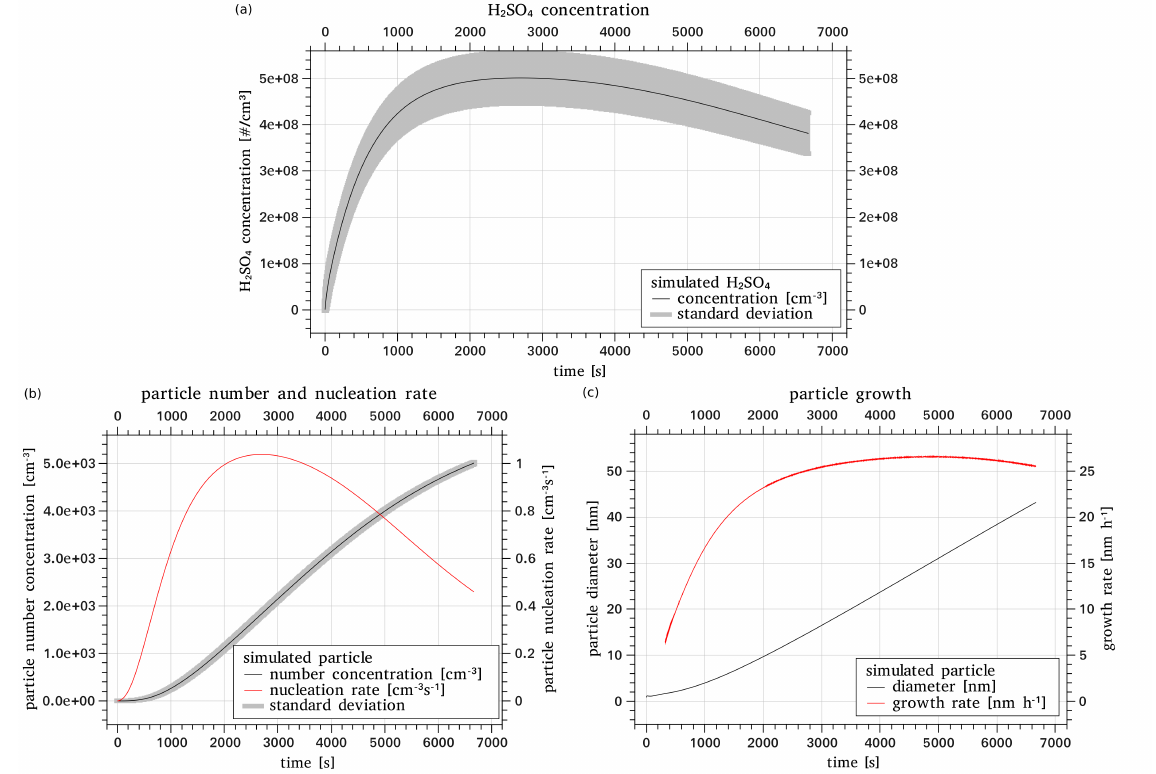
Fig. 9. Results of a simulation including particle nucleation and growth. Shown are calculated mean H 2 SO 4 concentration (a) , particle number concentration and nucleation rates (b) , and mean particle size and growth rates (c) . Details are given in the